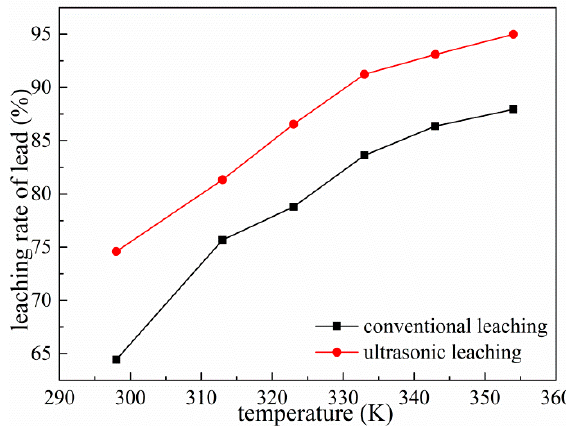
Figure 10. Effects of temperature on leaching of Pb. Figure 10. E ff ects of temperature on leaching of